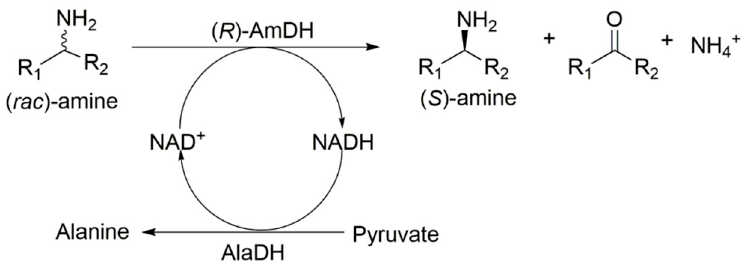
Figure 1. The oxidative deamination of racemic amines to enantiopure ( S )-amines using a two-enzyme cascadeemployingaminedehydrogenaseandalaninedehydrogenase. ( R )-AmDHcatalyzetheoxidative deaminationof( R )-aminetocorrespondingketone, leavingbehindenantiopure( S )-amine. Nicotinamide cofactors were recycled using alanine